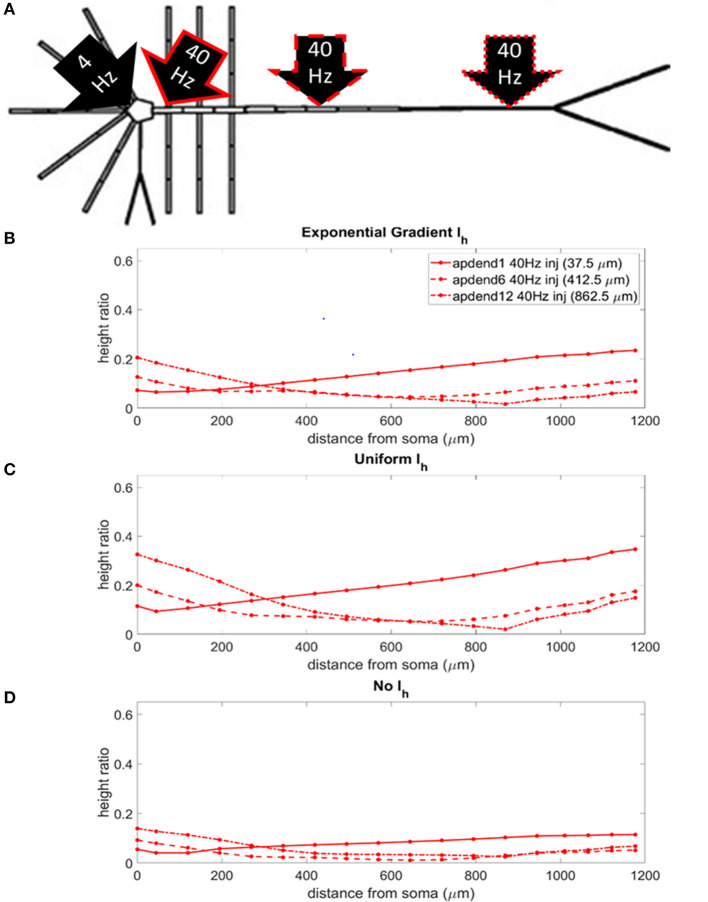
(A) Perisomatic 1.5 nA, 4 Hz modulation (black arrow) with 1.5 nA 40 Hz current injections in base of apical dendrite (black arrow, solid red outline), middle apical dendrite (black arrow, dashed red outline), and distal apical dendrite (black arrow, dot-dashed red outline). (B) Height ratio calculated for the soma, apical dendrite, and apical tuft in model with exponential gradient in Ih conductance density along apical dendrite. (C) Height ratio calculated for the soma, apical dendrite, and apical tuft in model with uniform Ih conductance density. (D) Height ratio calculated for the soma, apical dendrite, and apical tuft in model with no Ih conductance. Dot symbols along the profiles in (B–D) indicate the distance from the soma of compartments along the soma-apical dendrite axis and apical tuft (measured from the beginning of each compartment).